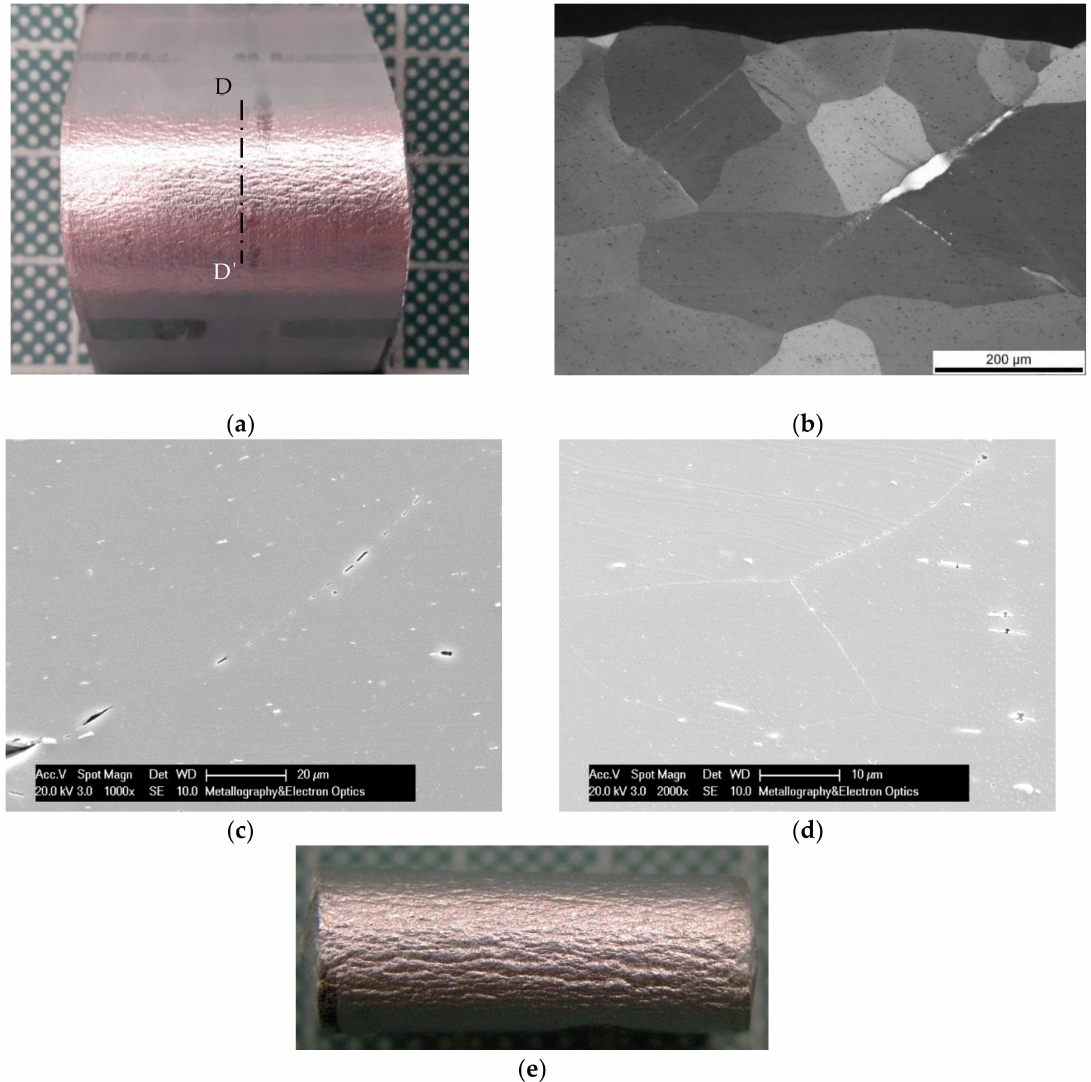
Figure 13. ( a ) Macroscopic image of bent specimen sample with 3.2 mm thickness (end of bending test at 10% load drop, longitudinal bend test with bend line transverse to extrusion direction). ( b ) Optical micrograph, cross-section D-D’ showing partly intergranular cracking on the surface. ( c , d ) SEM micrographs, grain boundary debonding and rupture. ( e ) Macrograph, end of bending test at 180